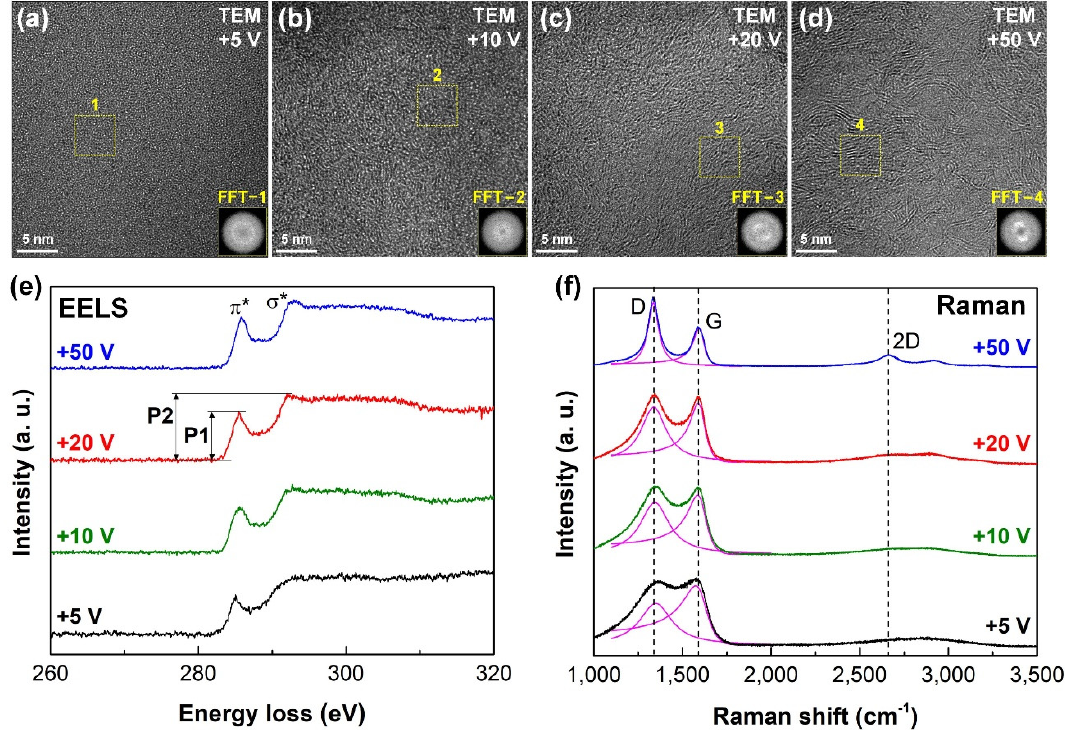
Figure 2. Characterization of the carbon films fabricated under different substrate bias voltages. HRTEM plan-view images of the carbon films deposited at substrate bias voltages of ( a ) +5 V, ( b ) +10 V, ( c ) +20 V, and ( d ) +50 V. Insets are the FFT images of the selected square region (marked with yellow dotted line). ( e ) EELS spectra and ( f ) Raman spectra of the carbon films. Table 1. EELS, Raman, and mechanical parameters of the carbon films produced at different sub- strate bias voltages.